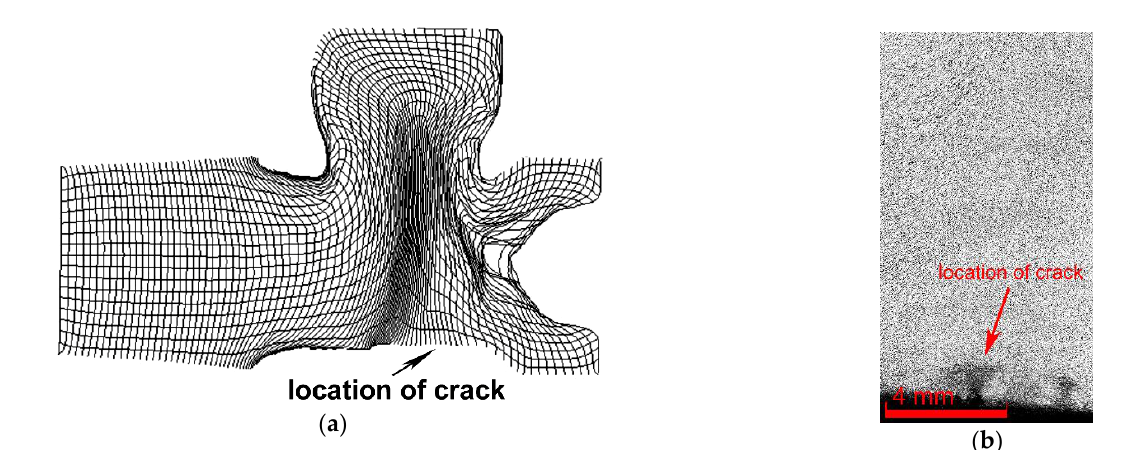
Figure 2. Plastic flow along the axial longitudinal cut through the brass fitting acquired via numerical simulation ( a ); detailed OM view of plastic flow in the vicinity of the crack within the real component ( b ).